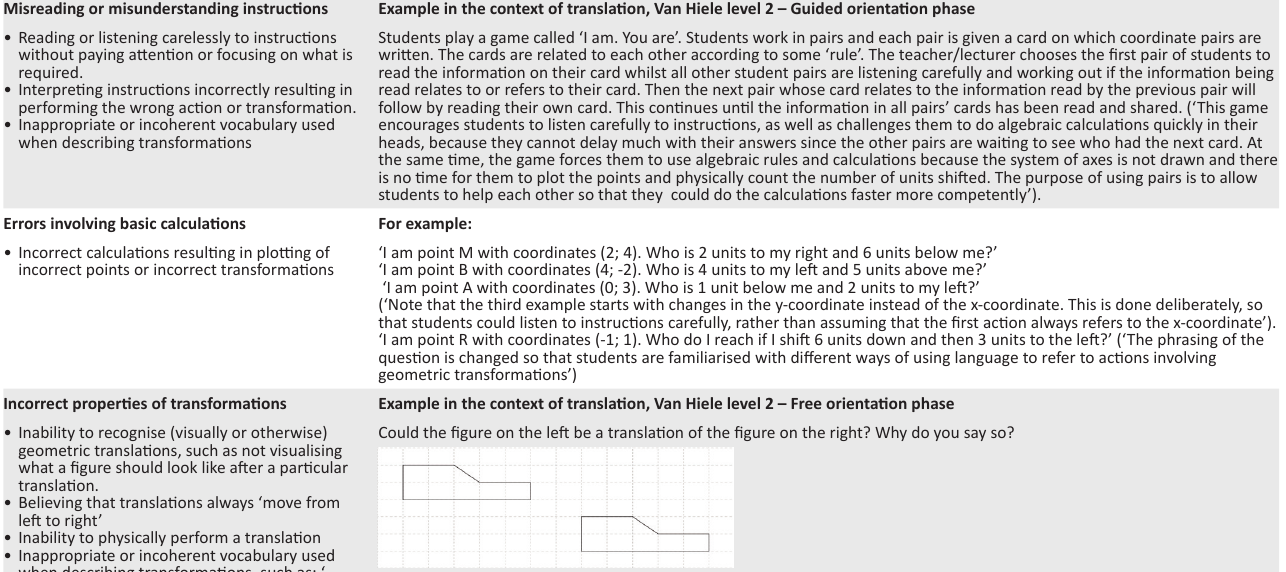
TABLE 5: Mapping errors and misconceptions to Van Hiele phase-based activities. Errors and